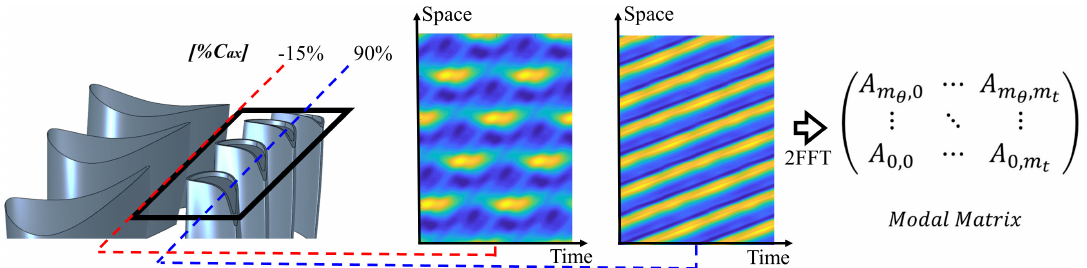
Figure 2. Modal decomposition of casing static pressure